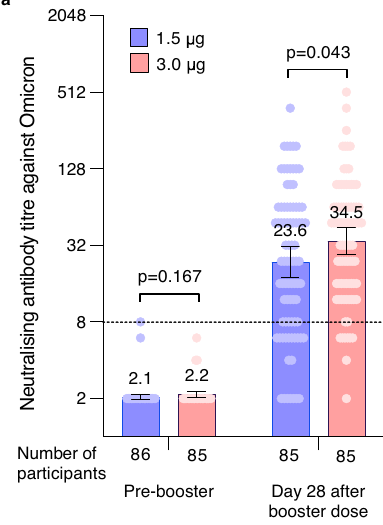
calculated on the basis of standard normal distributions of log-transformed anti- body titres. Numbers above the short horizontal lines are p values of comparisons between 1.5 μ g group and 3.0 μ g group using group t test with log-transformation (two-sided).Thedottedhorizontallinerepresentstheseropositivitythreshold(1:8). Titres lower than the limit of detection (1:4) are presented as half the limit of detection. GMT geometric mean titre.